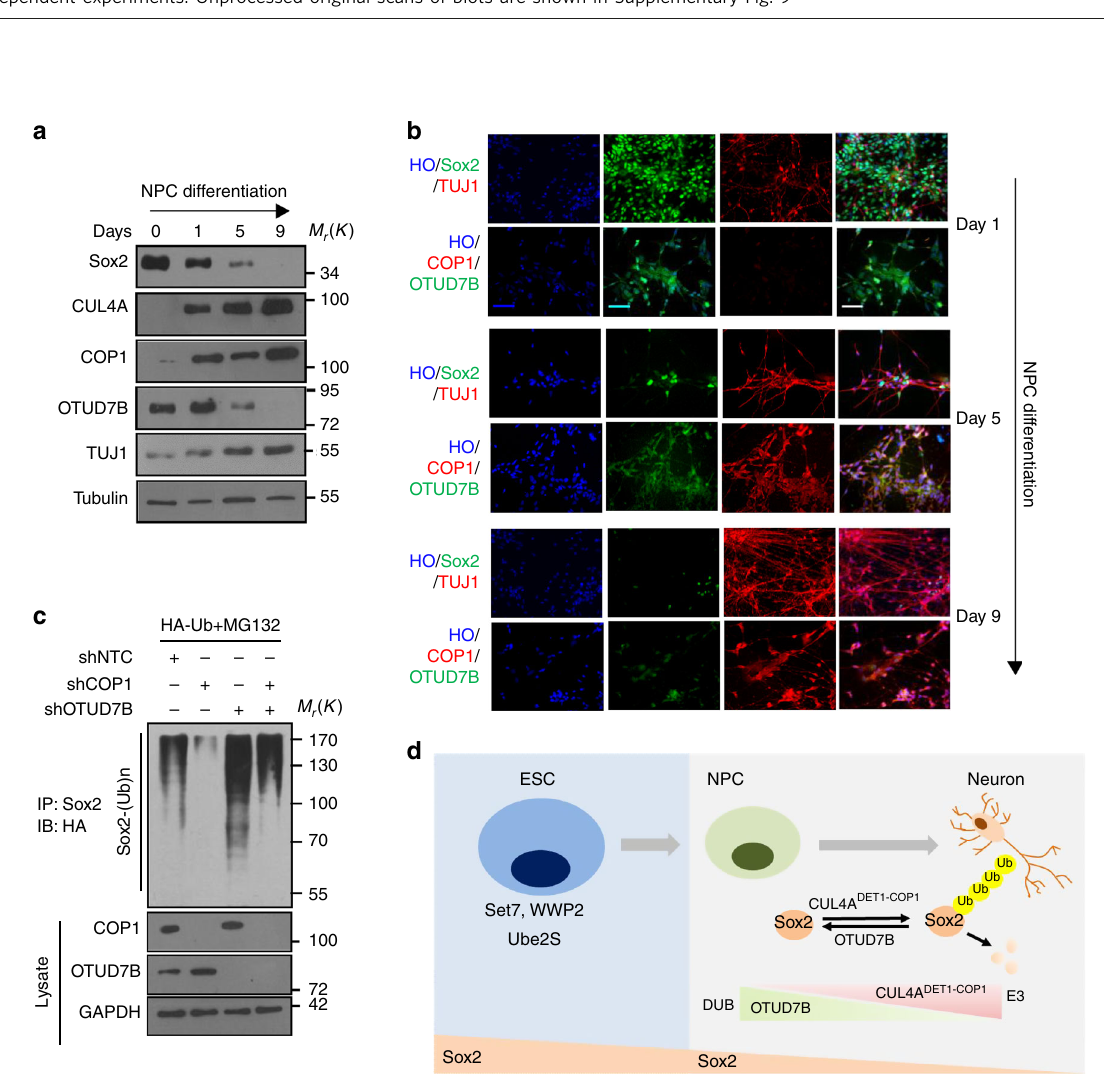
Fig. 7 OTUD7B maintains NPCs stemness. a Immunoblotting of Sox2 in MEF with OTUD7B knockout and WT control. b The MEF cells were treated with CHX (10 µ g/ml), and collected at the indicated times for western blot. Quanti fi cation of Sox2 levels relative to tubulin is shown. Results are shown as mean ± s.d. n = 3 independent experiments. ** P < 0.01, two-way ANOVA test. c Sox2 ubiquitylation in MEF with OTUD7B knockout and WT control. MEFs were treated with MG132 for 8 h and the lysates were subjected to immunoprecipitation with anti-Sox2 and immunoblotted with anti-Ub. d NPCs were plated in Matrigel-coated six-well plate for neuronal differentiation. For the indicated times, fi xed and stained with anti-OTUD7B (green). Nuclei were counterstained with HO (blue). e , f NPCs were infected with lentiviruses expressing OTUD7B shRNA or negative control (NC) shRNA for 126 h. Immunoblotting ( e ) and immunostaining ( f ) were used to detect the level of Sox2, TUJ1, or Nestin in NPCs. Scale bar, 50 µ m. g NPCs with stable OTUD7B knockdown and Sox2-AA overexpression were generated with lentivirus infection. Immunostaining were performed for Sox2, TUJ1. Scale bar, 50 µ m. The ratio of TUJ1-positive or Sox2-positive cells were quanti fi ed. Results are shown as mean ± s.d. Each error bar shows the standard deviation of numbers of positive cells in 10 fi elds of view. * P < 0.05. Student ’ s t -test. h NPCs with stable OTUD7B overexpression and Sox2 knockdown were generated with lentivirus infection. Cas9-based activator of OTUD7B (SAM-OTUD7B) were used to activate OTUD7B expression in NPCs. Immunostaining were performed for Sox2, TUJ1. Scale bar, 50 µ m. The ratio of TUJ1-positive or Sox2-positive cells were quanti fi ed. Results are shown as mean ± s.d. Each error bar shows the standard deviation of numbers of positive cells in 10 fi elds of view. * P < 0.05. Student ’ s t -test. The representative images are shown from three independent experiments. Unprocessed original scans of blots are shown in Supplementary Fig. 9